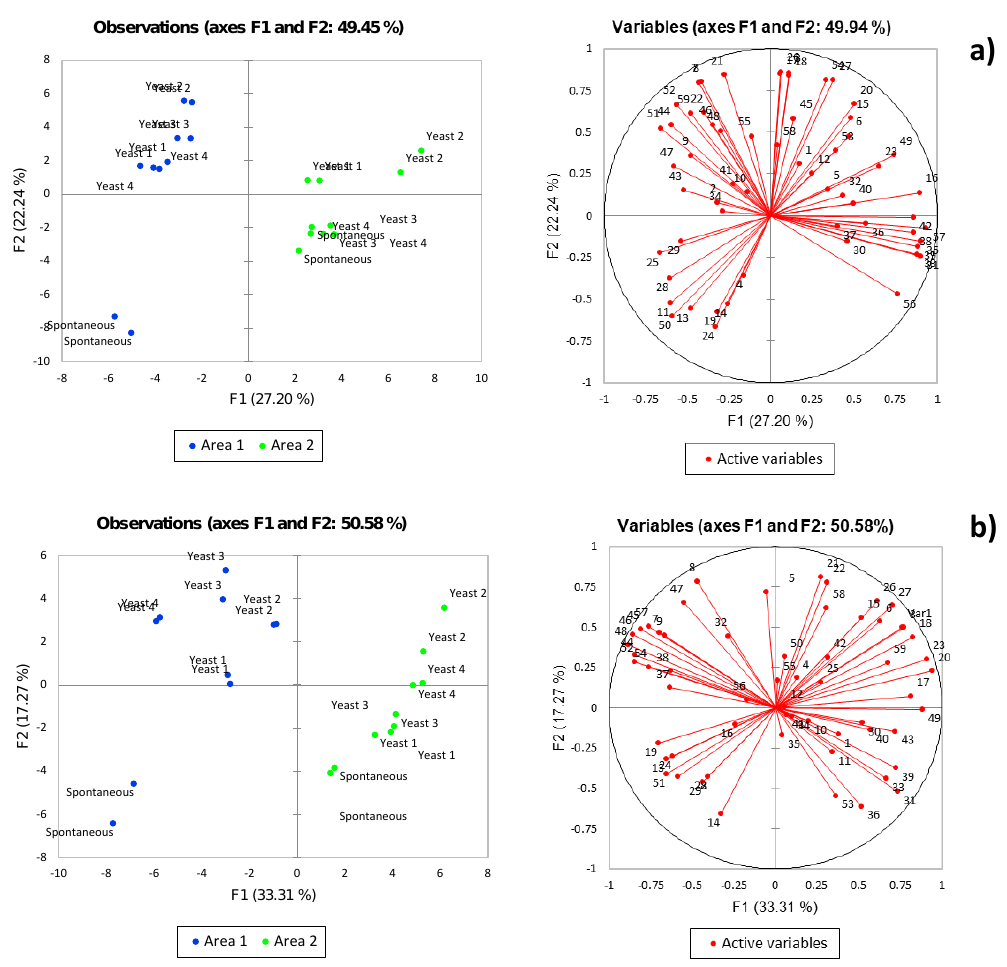
Figure 1. PCA of ( a ) Corvina and ( b ) Corvinone wines. Variables plot numbers correspond to: (1) 1-Butanol, (2) Butanol, (3) Isoamyl alcohol, (4) 1-Pentanol, (5) Methionol, (6) Phenylethyl alcohol, (7) 1-Hexanol, (8) trans -3-Hexen-1-ol, (9) cis -3- Hexen-1-ol, (10) cis -2-Hexen-1-ol, (11) Isoamyl acetate, (12) n-Hexyl acetate, (13) 2-Phenylethyl acetate, (14) Ethyl acetate, (15) Ethyl-2-methylbutanoate, (16) Ethyl 3-methylbutanoate, (17) Ethyl butanoate, (18) Ethyl hexanoate, (19) Ethyl lactate, (20) Ethyl octanoate, (21) Ethyl 3-hydroxybutanoate, (22) Ethyl 2-hydroxyhexanoate, 23) Ethyl decanoate, (24) Acetic acid, (25) 3-Methylbutanoic acid, (26) Hexanoic acid, (27) Octanoic acid, (28) cis -Linaloloxide, (29) trans -Linaloloxide, (30) 3-carene, (31) α -Phellandrene, (32) α -Terpinene, (33) β -Myrcene, (34) 1,4-Cineole, (35) Limonene, (36) 1,8-cineole, (37) p-Cymene, 38) Terpinolene, (39) Linalool, (40) Geraniol, (41) Terpinen-4-ol, (42) α -Terpineol, (43) β -Citronellol, (44) β -Damascenone, (45) TPB (E)-1-(2,3,6-Trimethylphenyl)-buta-1,3-diene), (46) TDN (1,6,-trimethyl-1,2-dihydronapthalene), (47) 3-Hydroxy- β - damascone, (48) Vitispirane, (49) Furfural, (50) Benzaldehyde, (51) Benzyl alcohol, (52) Eugenol, (53) 2,6-Dimethoxyphenol, (54) Vanillin, (55) Methyl vanillate, (56) Ethyl vanillate, (57) Methyl salicylate, (58) γ -Decalactone, (59) δ